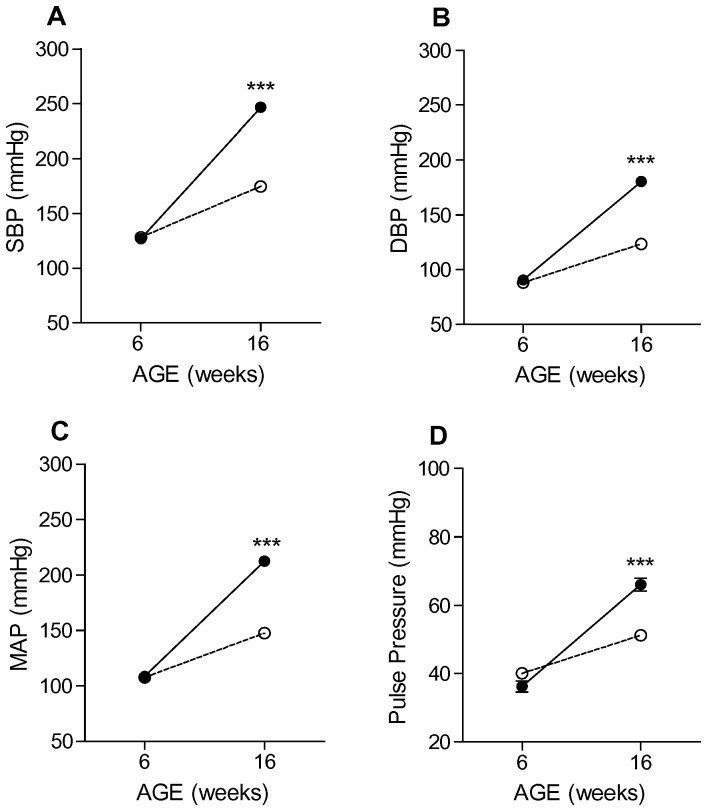
Development of high blood pressure in stoke-prone (SP) and non stroke-prone (nSP) Dahl S female rats.Systolic (A), diastolic (B), mean arterial (C) and pulse (D) pressures in SP Dahl S (n = 4, closed circles) and nSP Dahl S (n = 6, open circles) female rats. Blood pressure parameters were collected at 6 and 16 weeks of age. Values are means ± s.e.m. ***P<0.001, (Two Way ANOVA followed by Holm-Sidak Test for multiple comparisons).